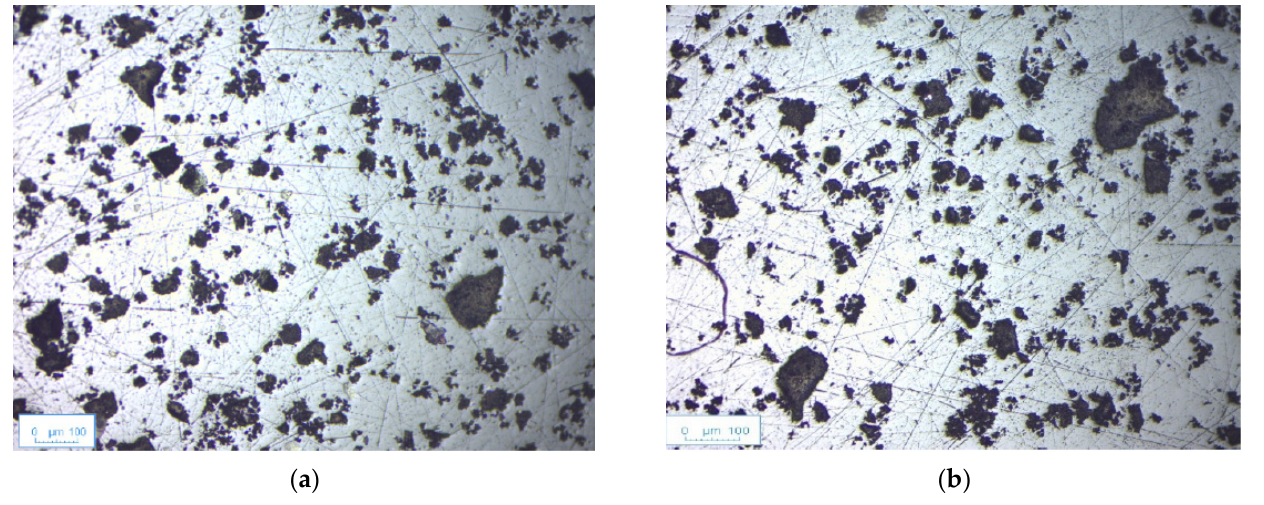
Figure 12. Microstructural observation of ( a ) LR2G10; ( b ) LR20 by means of TLM [53].